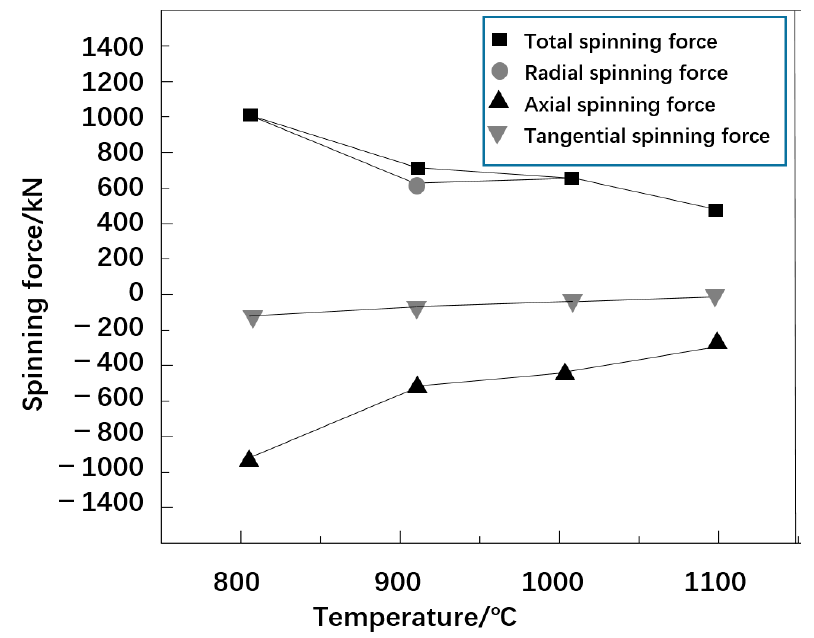
Figure 4. The curve of spinning pressure with temperature.